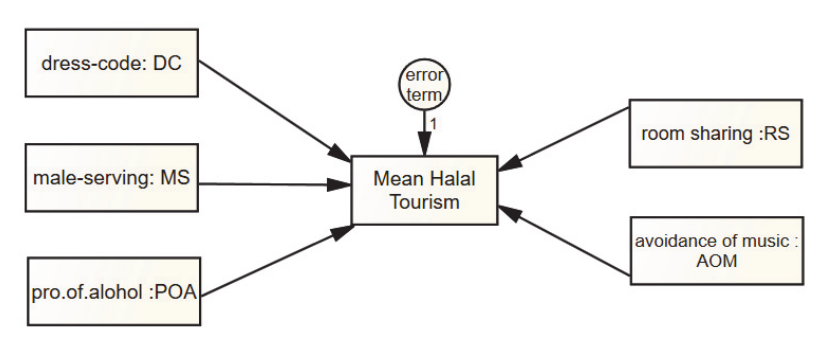
Fig. 2. Impact of General Islamic Values on Halal Tourism